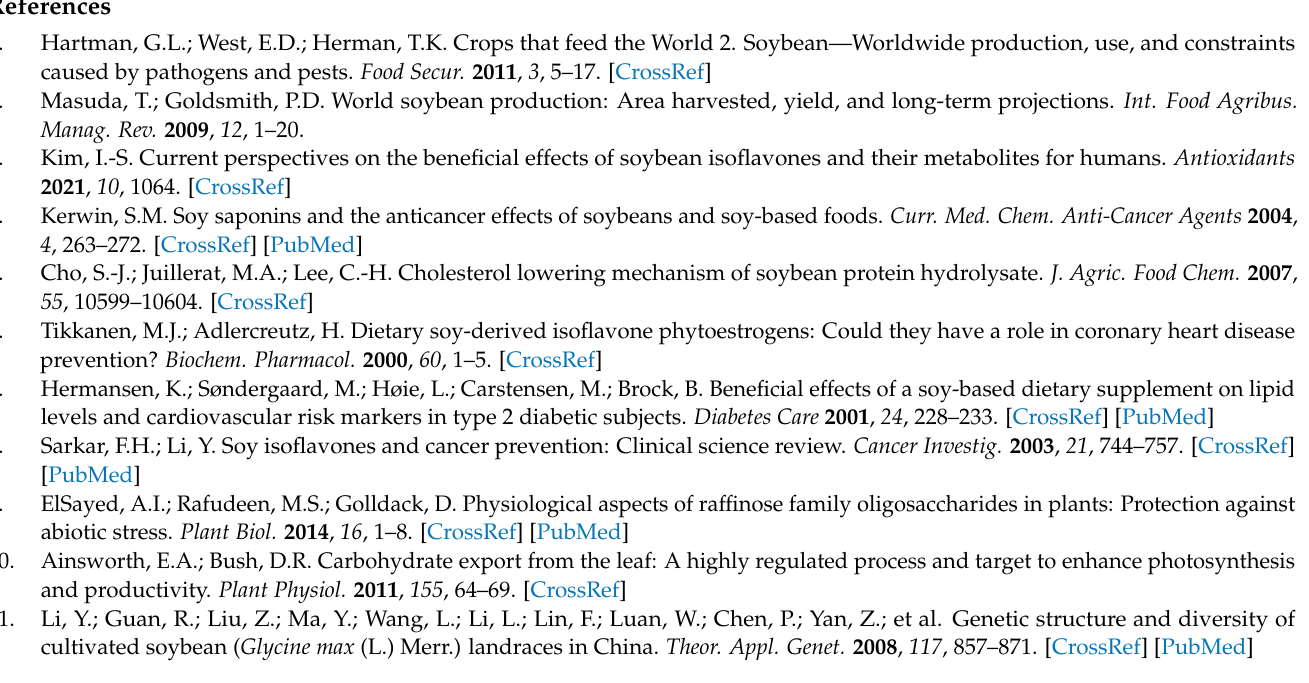
Table S10. Composition and content ( µ g/g) of lipophilic compounds in soybean leaves with GC-MS and HPLC